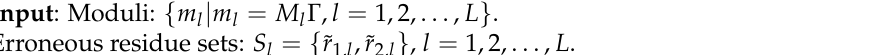
Algorithm 1 Robust frequency estimation for the single-tone real